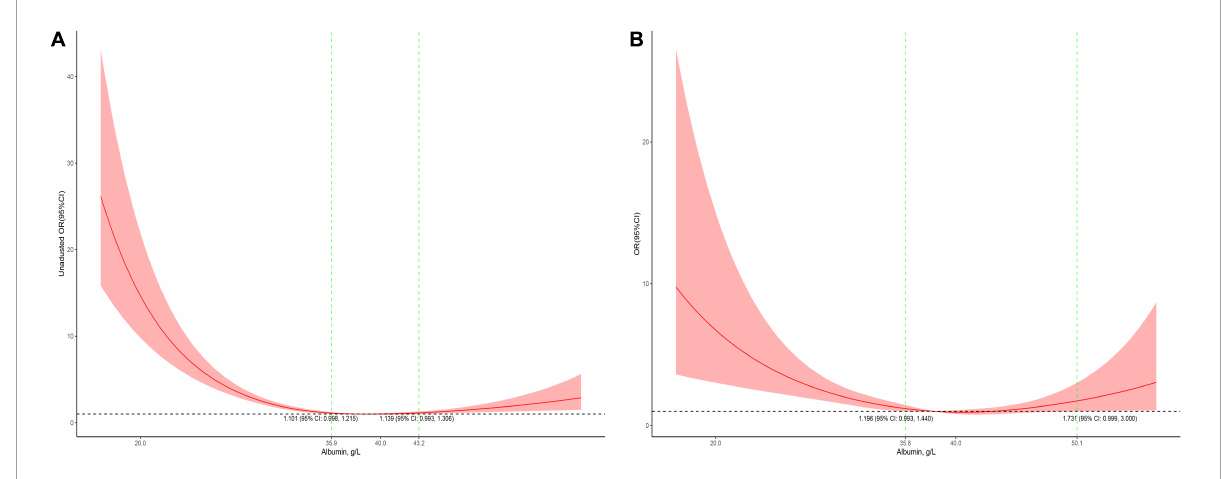
FIGURE1 Association between serum albumin levels and mortality in all patients ( A , the crude model; B, the model adjusted for age, race, sex, admission form emergency department, cardiac surgery, PO 2 , PCO 2 , shock index, RR, bilirubin, eGFR, mechanical ventilation, inotropes, AKI, and PRISM). Y-axis present the odds ratio, and the X-axis present albumin values. The 95% CI included an OR of 1.0 at albumin concentrations between 35.9 and 43.2 g/L in the crude model and between 35.9 and 50.1 g/L in the adjusted model.